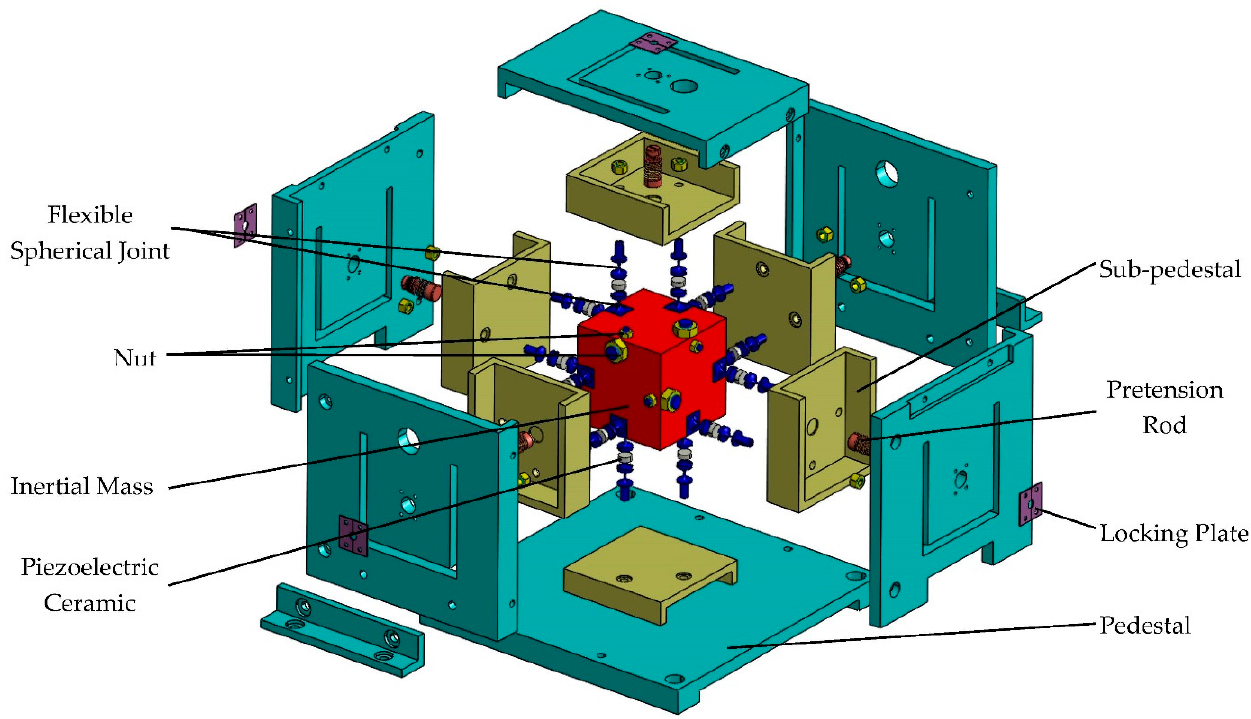
Figure 2. The exploded 3-D drawing of the six-axis accelerometer.